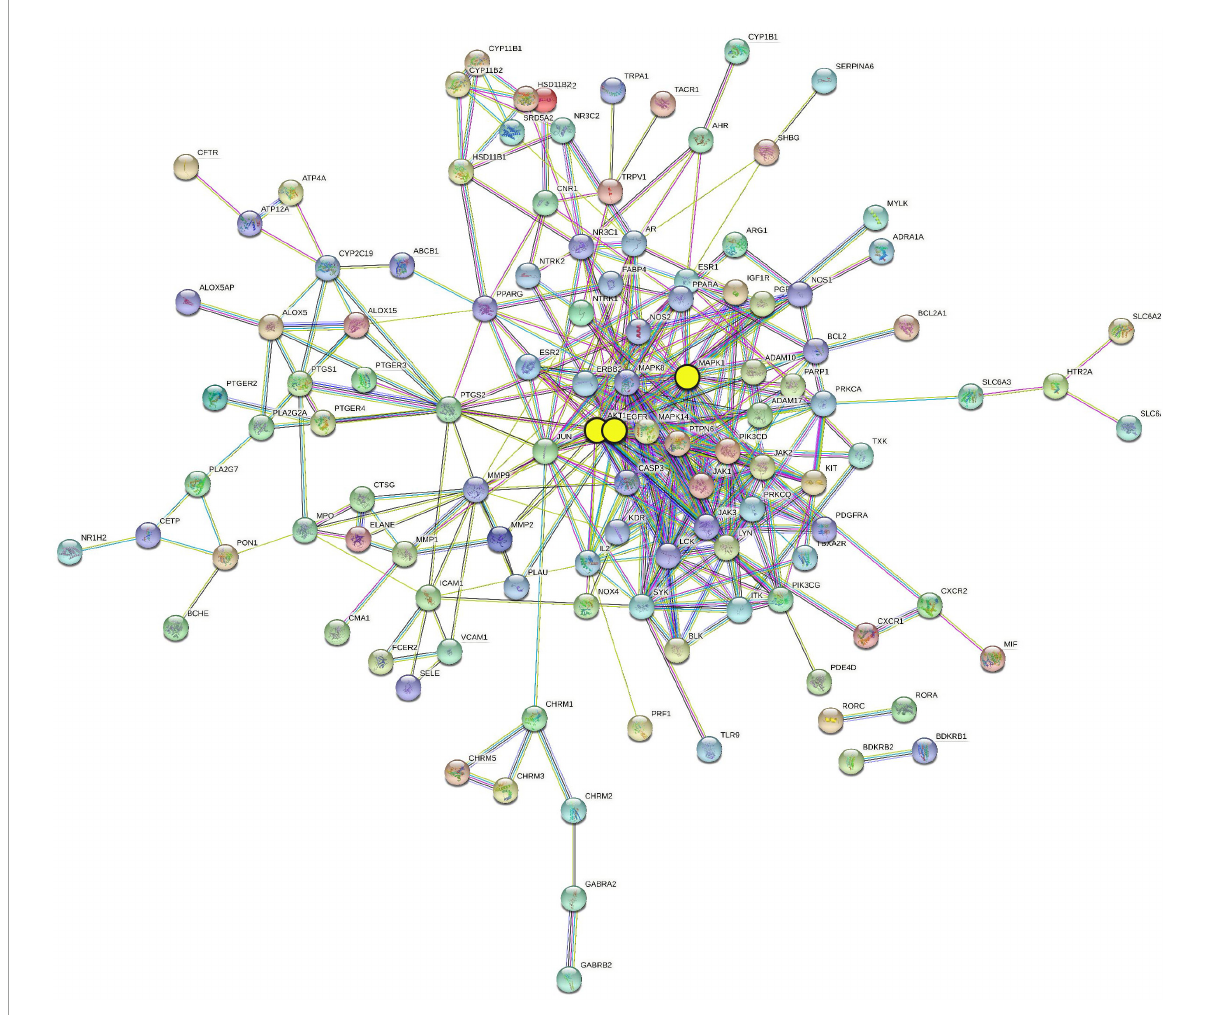
FIGURE5 Protein–protein interaction (PPI) network of 140 AR/YPFS-related genes. The three yellow circles represent the selected genes: EGFR, MAPK1, and